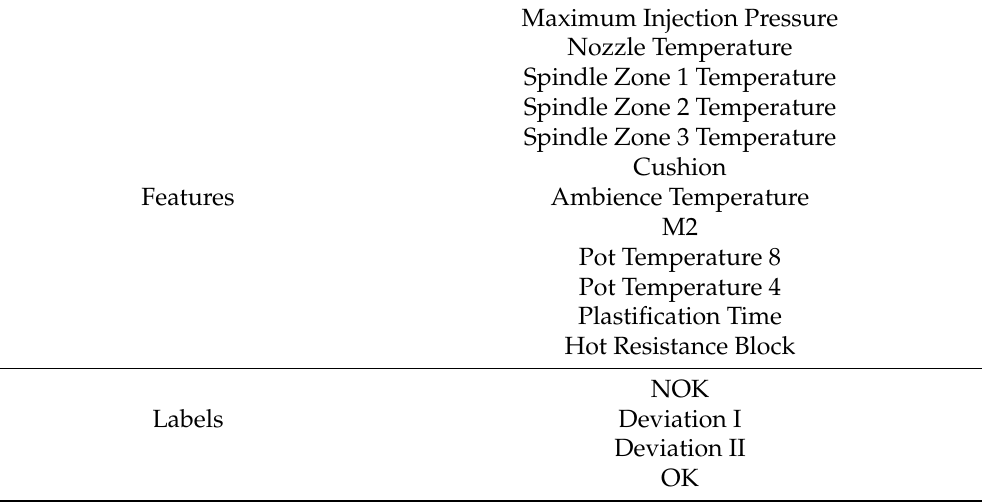
Table 4. Features and Labels of the Nissei ASB dataset.